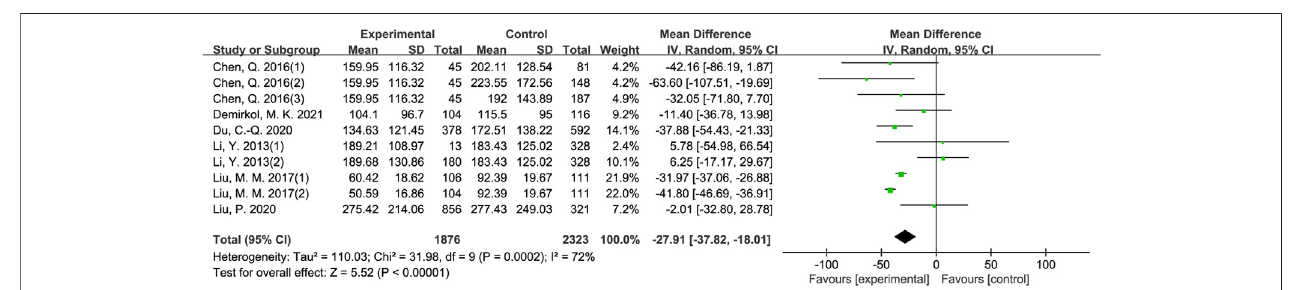
FIGURE 2 | Forest map evaluating the effects of sleep disorders on total sperm